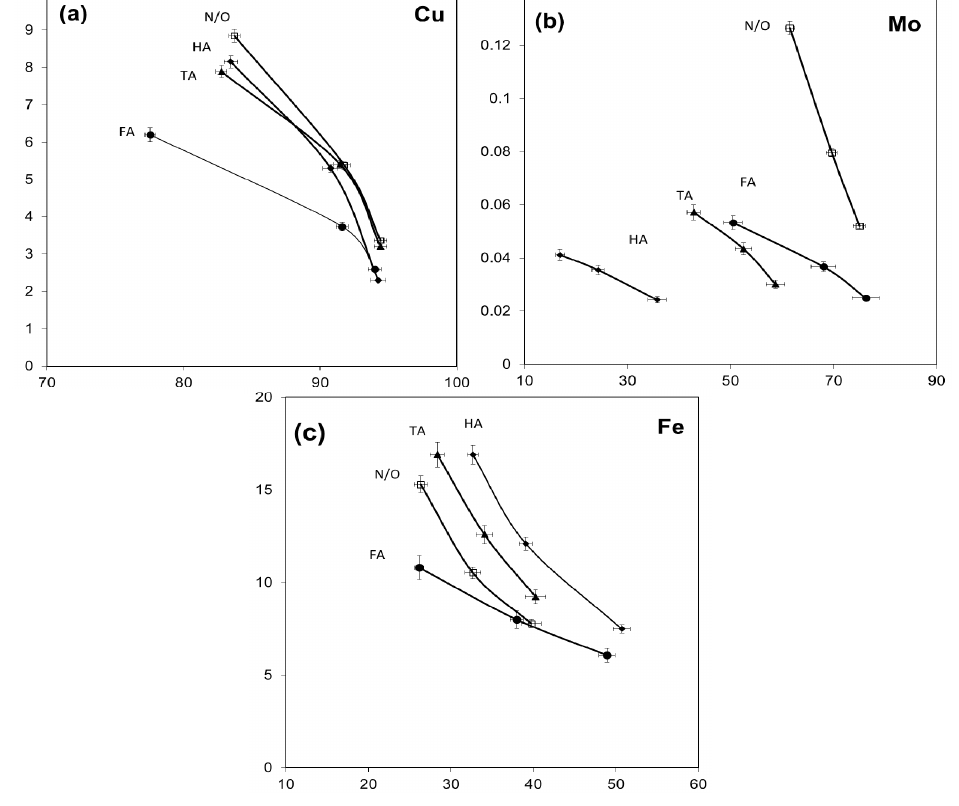
Figure 3. Grades versus recoveries of Cu ( a ), Mo ( b ), and Fe ( c ) in the bulk Cu–Mo flotation concentrate without (N/O) and with the addition of 20 mg/L of organic matter at pH 10.5.